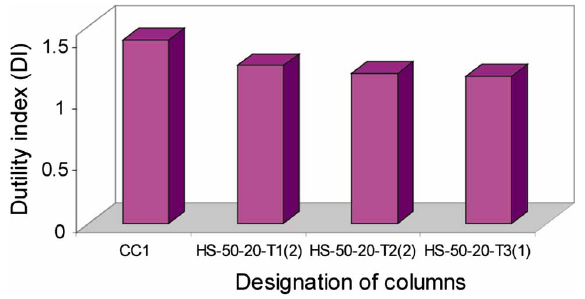
Fig. 20. Ductility Index for columns HS-50-20